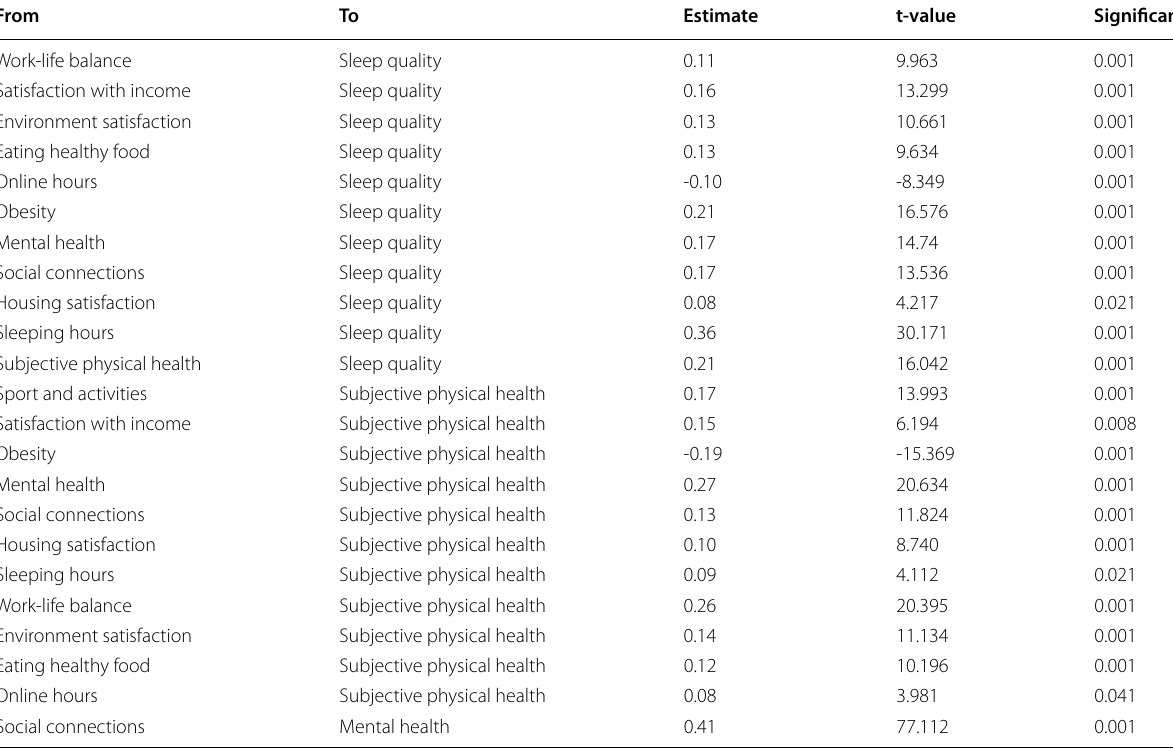
Table 6 Final model path estimates and t-values From